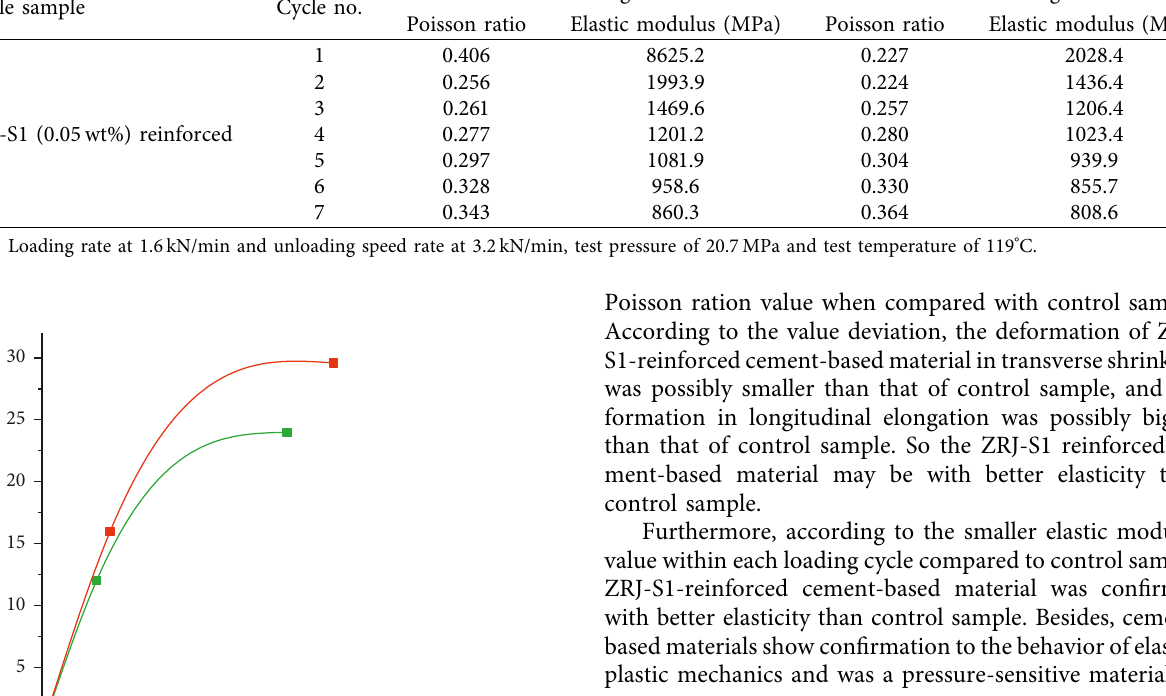
Table 6: Mechanical parameters of cycle peak (ZRJ-S1 (0.05wt%) reinforced). Cycle sample